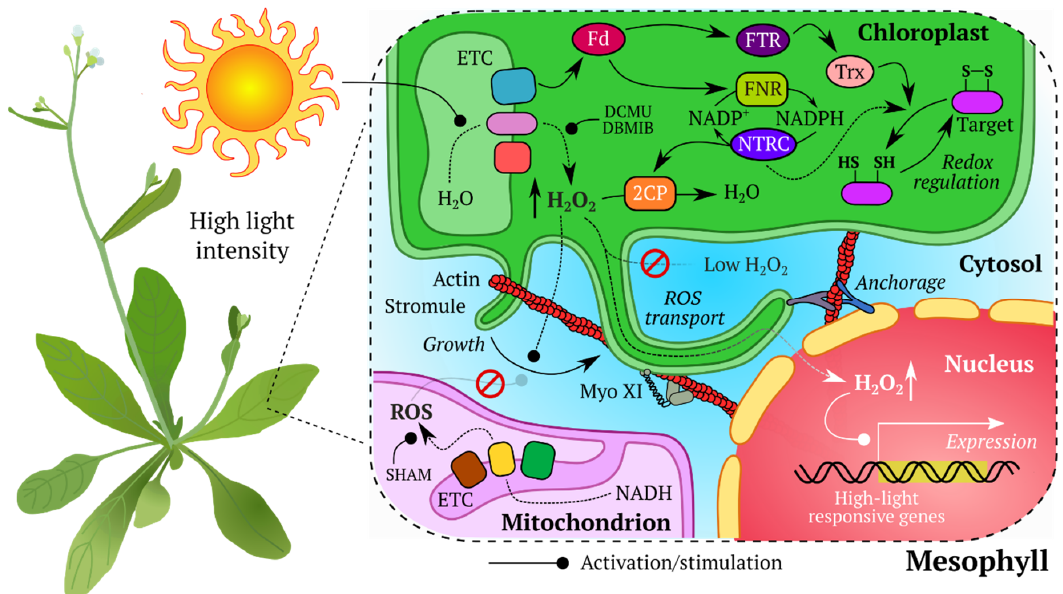
Figure 4. Schematic illustration of redox events during light-inducible reaction in photosynthetic leaves of A. thaliana . Plants sense light with the pigments of the photosynthetic electron transport chain (ETC) in the chloroplast or with photoreceptors. Chloroplasts generate stromules in response to the changes in the internal chloroplast redox status in a pathway regulated by the chloroplast NADPH-dependent thioredoxin reductase, NTRC. Stromules deliver H 2 O 2 directly to the nucleus bypassing the cytosol. Chloroplast-sourced H 2 O 2 in the nucleus may act as a signal to induce gene expression, which facilitates the acclimation of cells to high light intensities [163,187,188]. Abbreviations: 2CP—2-Cys peroxiredoxin; Myo—myosin; FTR—(Fd)-dependent Trx reductase; DBMIB—2,5-dibromo-6-isopropyl-